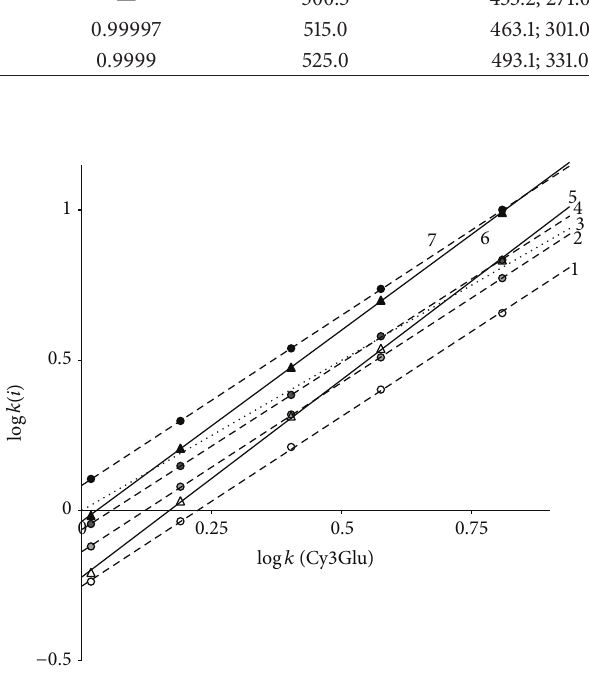
Figure 6: Separation map of cyanidin-3-glycosides: Cy3Sopho (1); Cy3AGlu (2); Cy3Glu (3); Cy3Sam (4); Cy3GRut (5); Cy3XRut (6); and Cy3Rut (7) in System 1. Chromatographic column: 4.6 × 250 mm Symmetry C 18